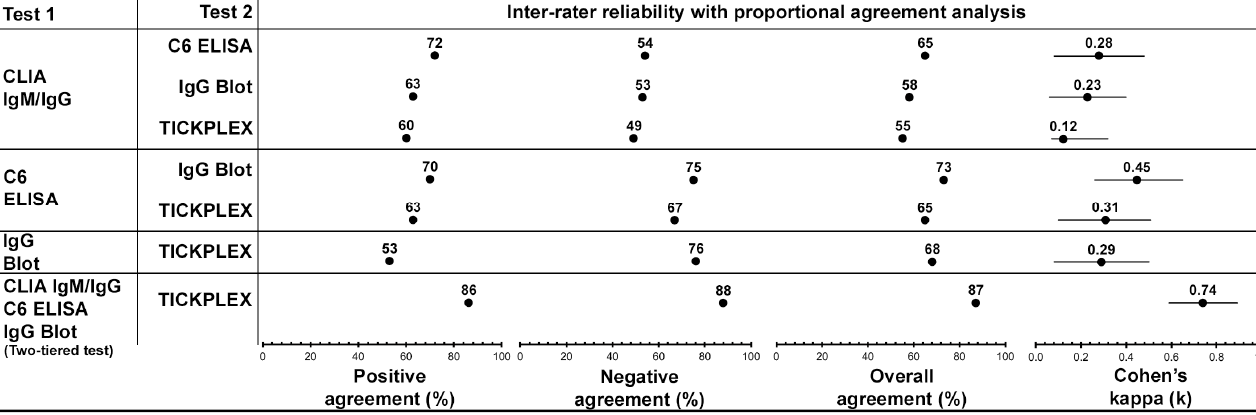
Figure 1. TICKPLEX ® can aid replace the need for four Lyme disease diagnostic tests, as the index test clinical performance substantially agrees with the Centers for Disease Control and Prevention (CDC) two-tier system. The collective immunoglobulin M/immunoglobulin G (IgM/IgG) inter-rater reliability (i.e., Cohen’s k ) and proportional agreement analysis (i.e., positive, negative, and overall agreement) among reference tests and between the reference tests with the index test. Herein, reference tests refer to Diasorin LIAISON®Borrelia chemiluminescence immunoassay (CLIA),